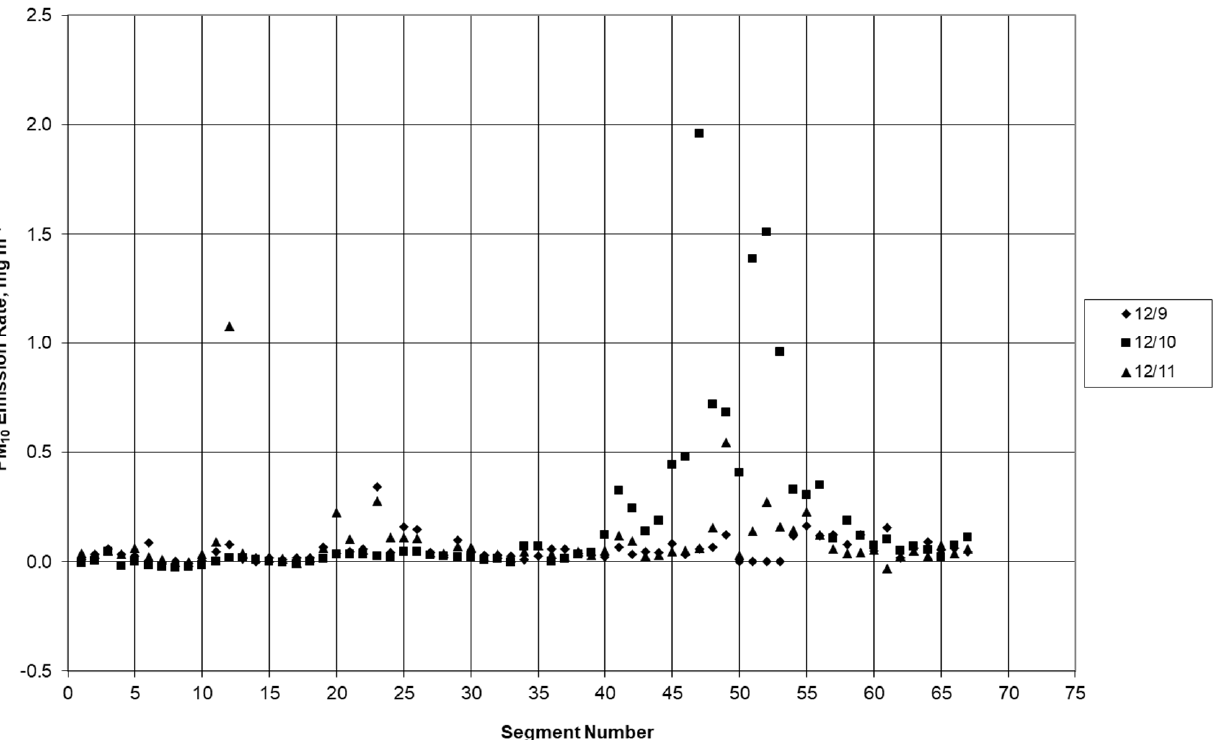
Figure 7. Plot of PM 10 emission rate by segment number starting Saturday December 9th.